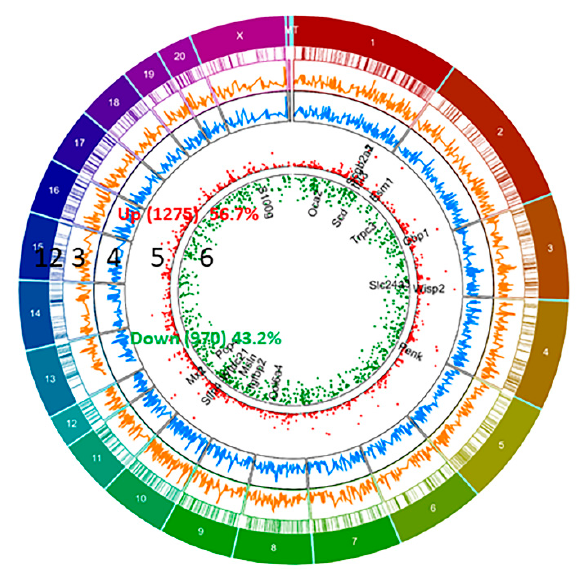
Figure 2. Circos plot of differentially expressed genes (DEGs) between pregnant and non-pregnant UA. DEGs more than 1.5 fold ( P < 0.05, paired test) are presented as scatter plot expression levels are presented as green (Down, track 6) and red (Up, Track 5). FPKM of DEGs- non-pregnant (Blue, track 4) and pregnant (Orange, track 3) are presented as continuous lines. DEG locations are presented as rectangular lines (track 2) along with chromosomes (track 1).